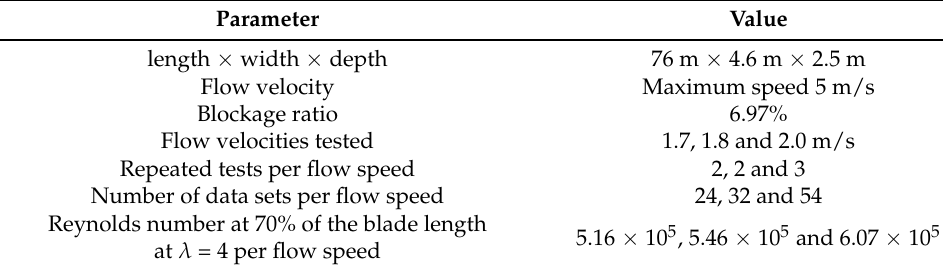
Figure 3. Turbine installed at the Kelvin Hydrodynamics Laboratory. Table 1. Kelvin Hydrodynamics Laboratory